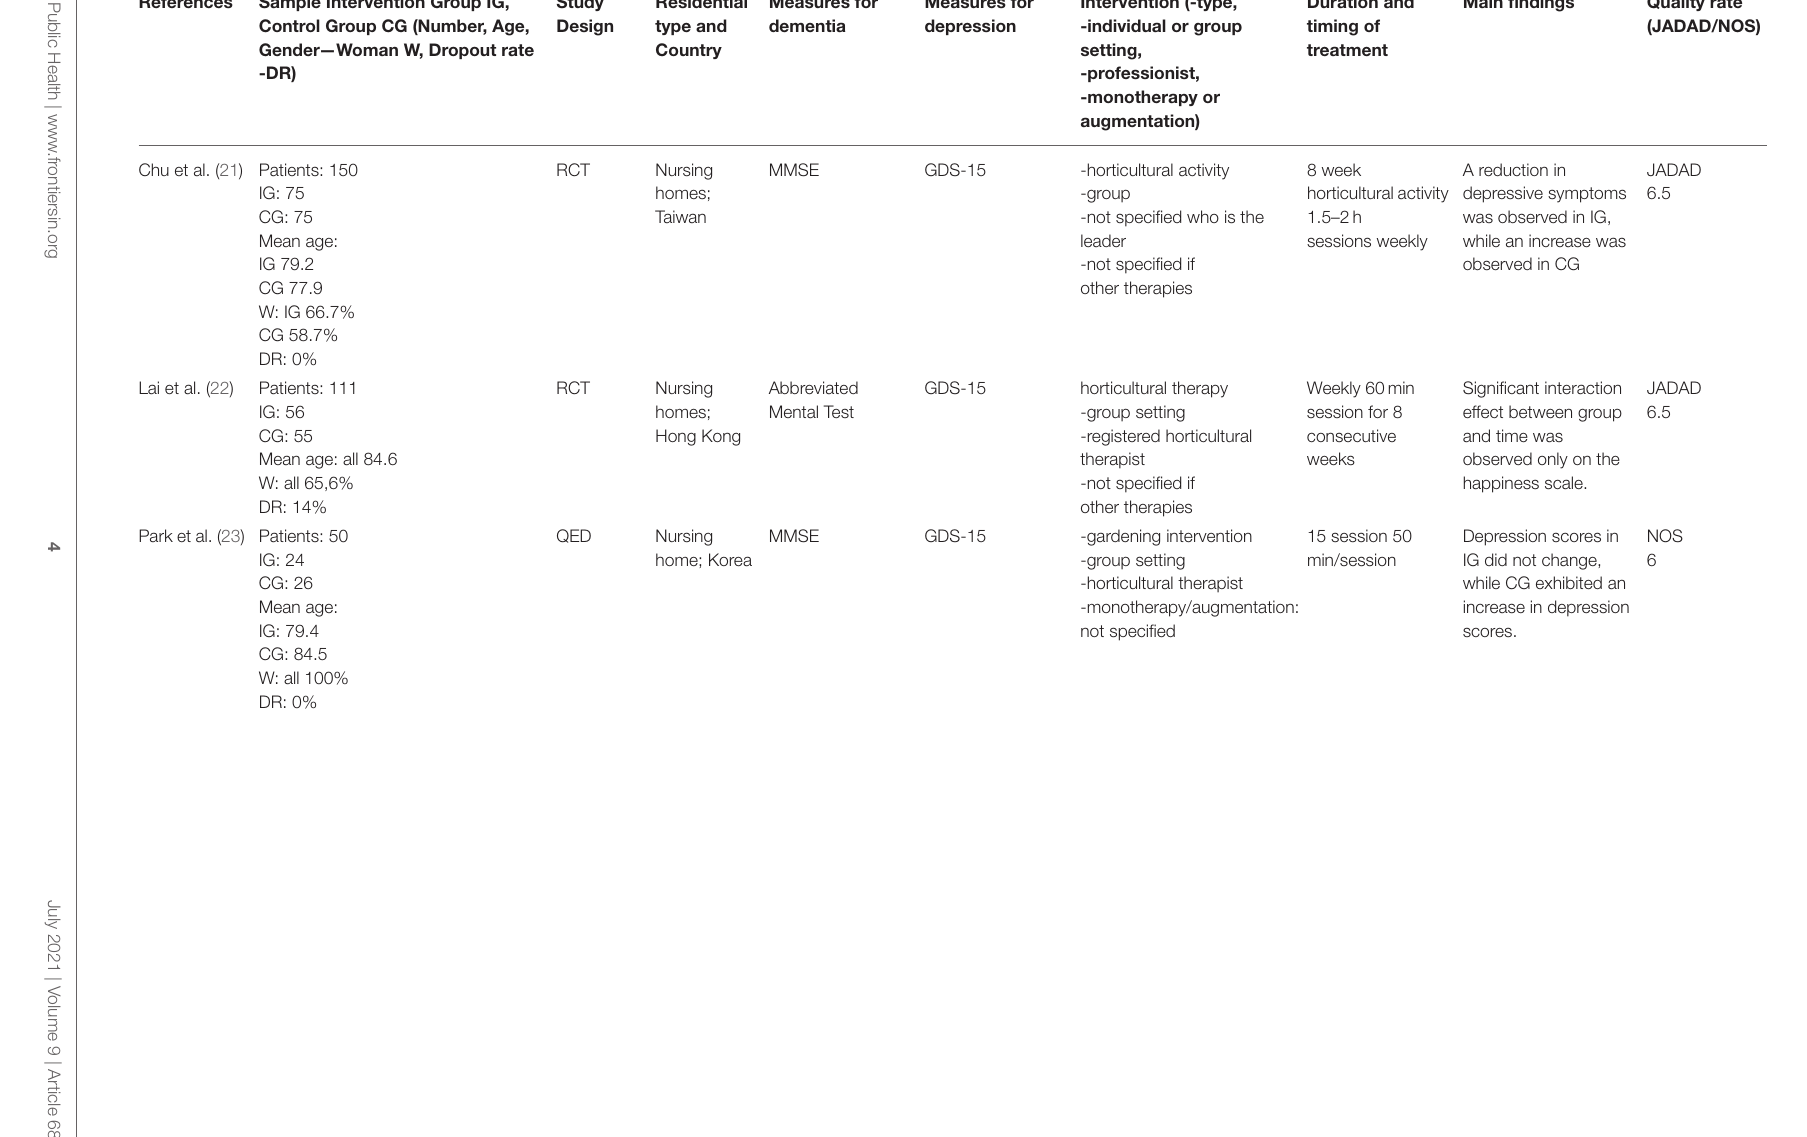
TABLE 1 | Horticulture and gardening studies (n 3 articles). Sample Intervention Group IG, Control Group CG (Number,